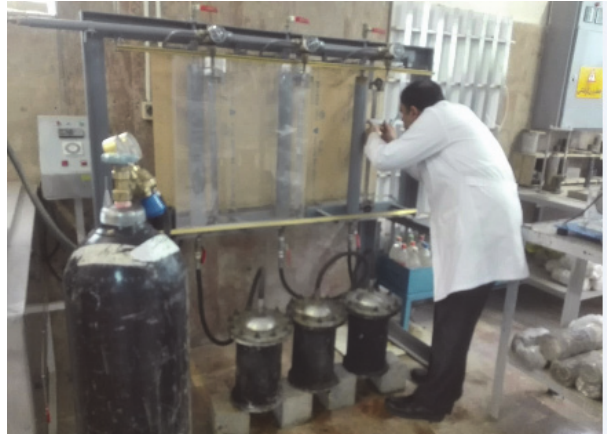
Figure 4: Hydraulic conductivity of the concrete test machine